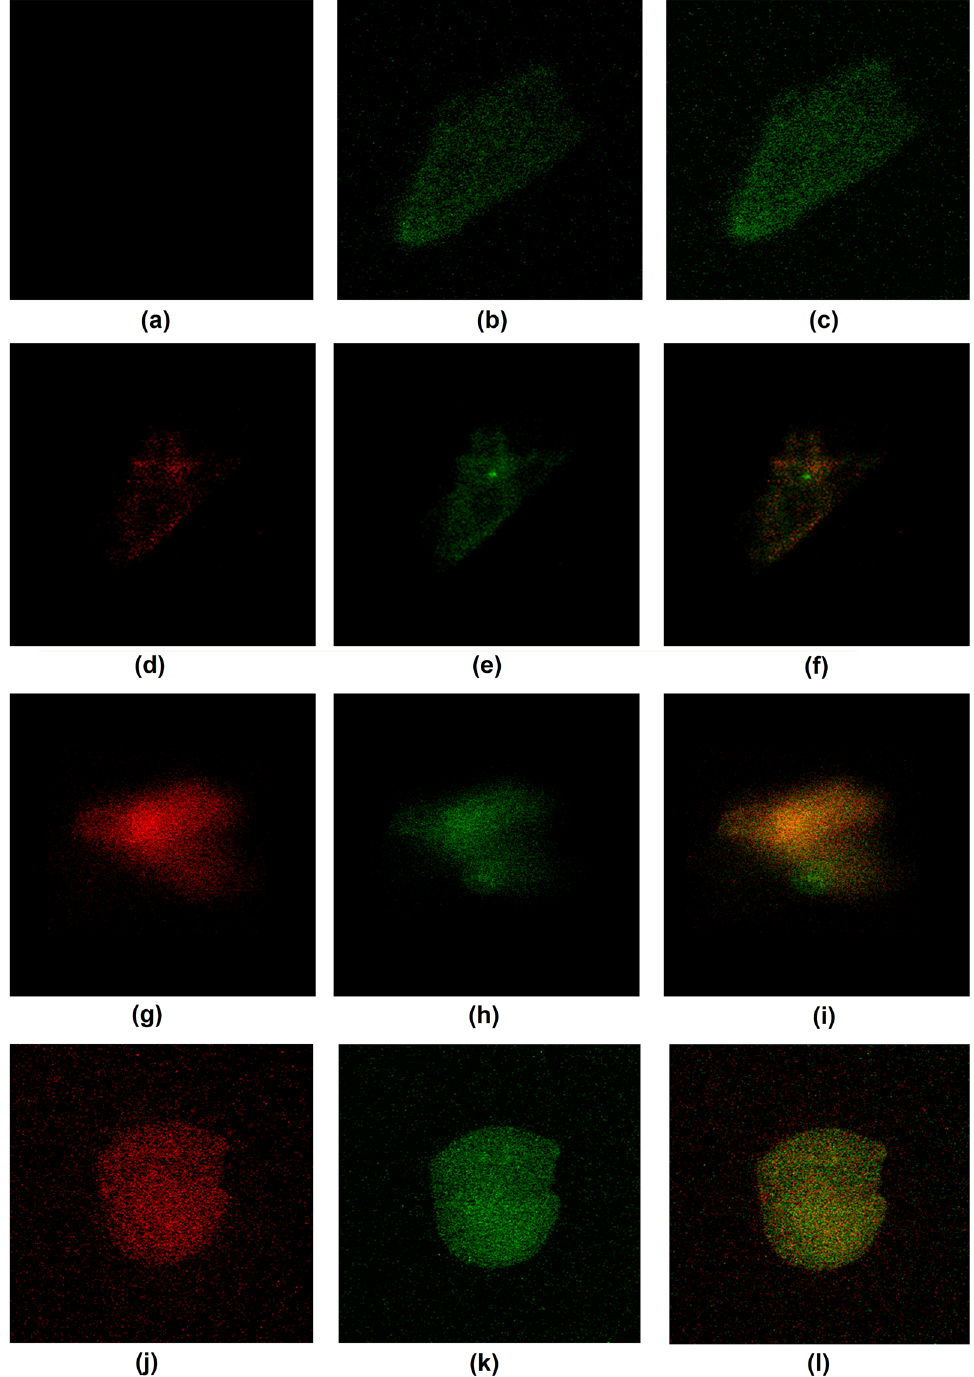
Figure 3. Confocal microscopic images showing antibody-antigen complex formation ( a – c ) zero IgG antigen concentration with only antibody visible (green), ( d – f ) 3 µ g/ml IgG antigen (red) and IgG antibody (green), complex (orange), ( g – i ) 6 µ g/ml IgG antigen (red), antibody (green), complex (orange), ( j–l ) NF- κ B 400 ng/ml antigen (red), NF- κ B antibody (green), complex